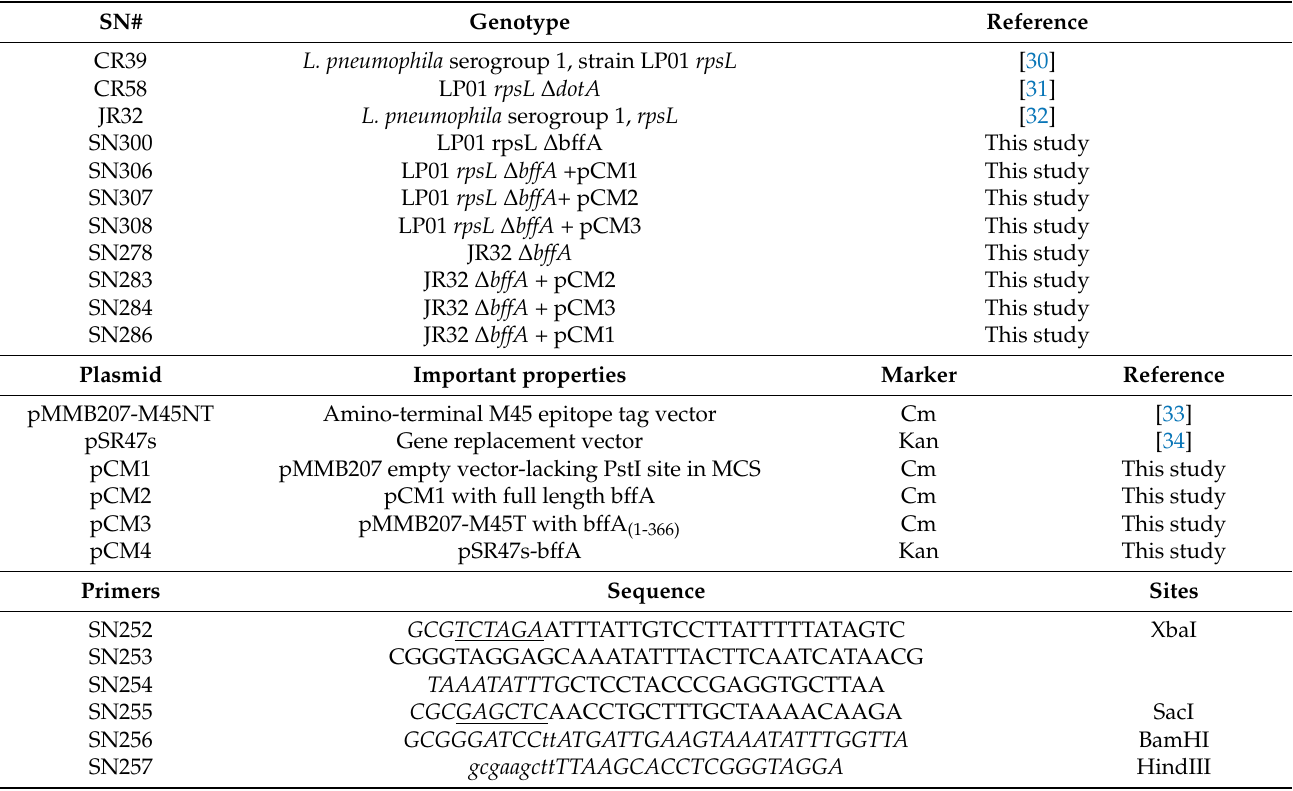
Table 1. Strains, Plasmids, and